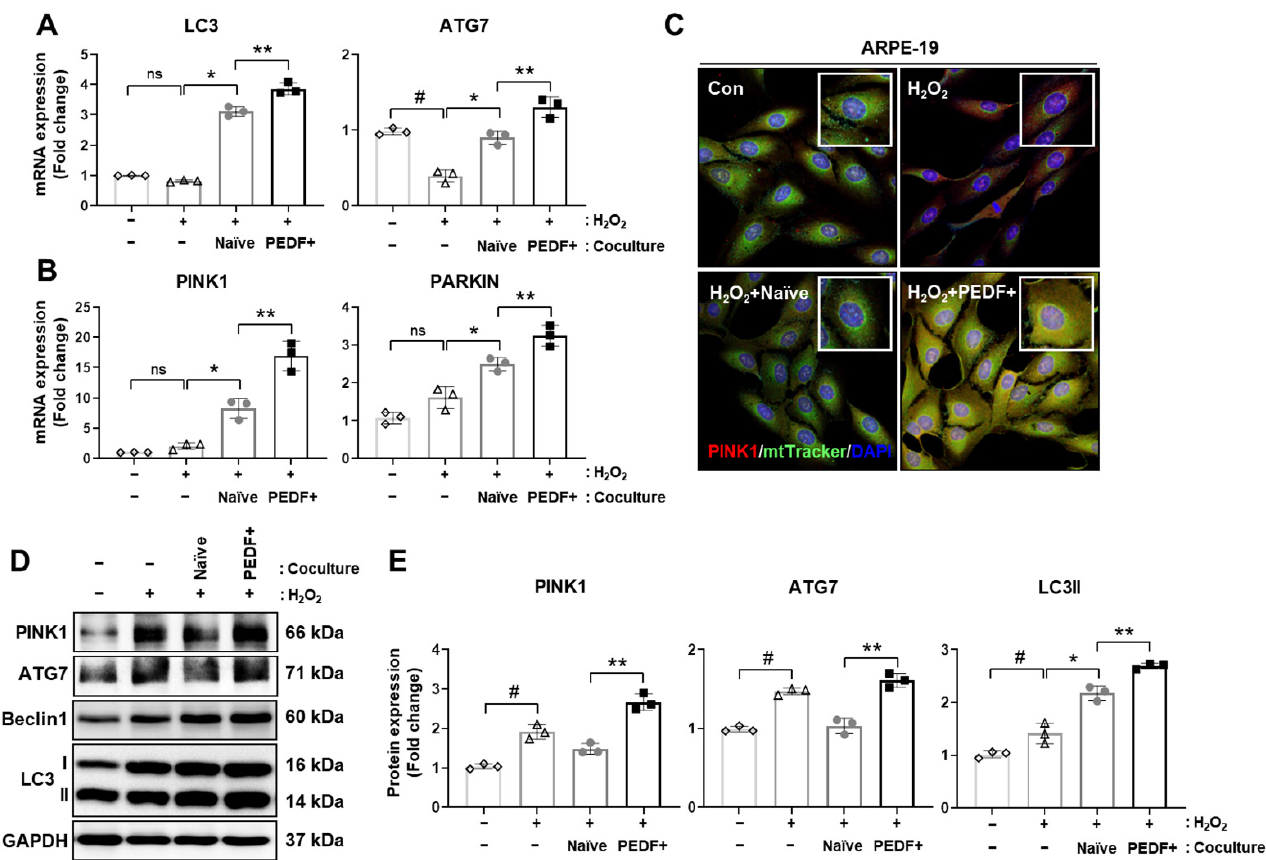
Figure 6. Coculturing RPE cells with PD-MSCs PEDF enhances mitophagy. The mRNA expression of ( A ) autophagy markers (e.g., LC3 and ATG7) and ( B ) mitophagy markers (e.g., PINK1 and PARKIN) in H 2 O 2 -injured ARPE-19 cells cocultured with naïve PD-MSCs (H 2 O 2 + Naïve) or PD-MSCs PEDF (H 2 O 2 + PEDF+) for 24 h was measured by qRT-PCR. ( C ) Immunostaining of PINK1 (red) and mtTracker (50 nM; green) in ARPE-19 cells. DAPI was used for counterstaining. Scale bar = 100 µ m. ( D ) The protein expression and ( E ) intensities of autophagy and mitophagy markers in ARPE-19 cells measured by Western blotting. The data represent the mean ± SD and were analyzed by one-way ANOVA. # p < 0.05 vs. normal control ( − ), * p < 0.05 vs. H 2 O 2 , ** p < 0.05 vs. Naïve.